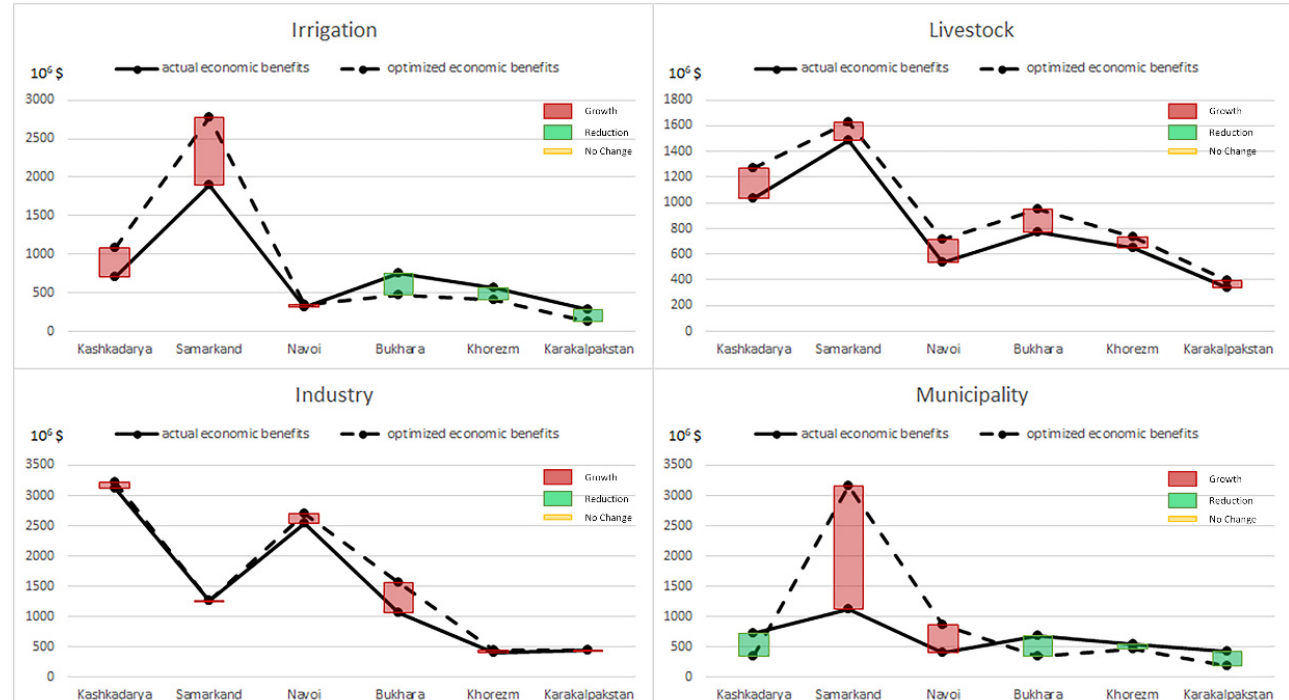
Figure 6. Comparison between actual economic benefits and optimized economic benefits.